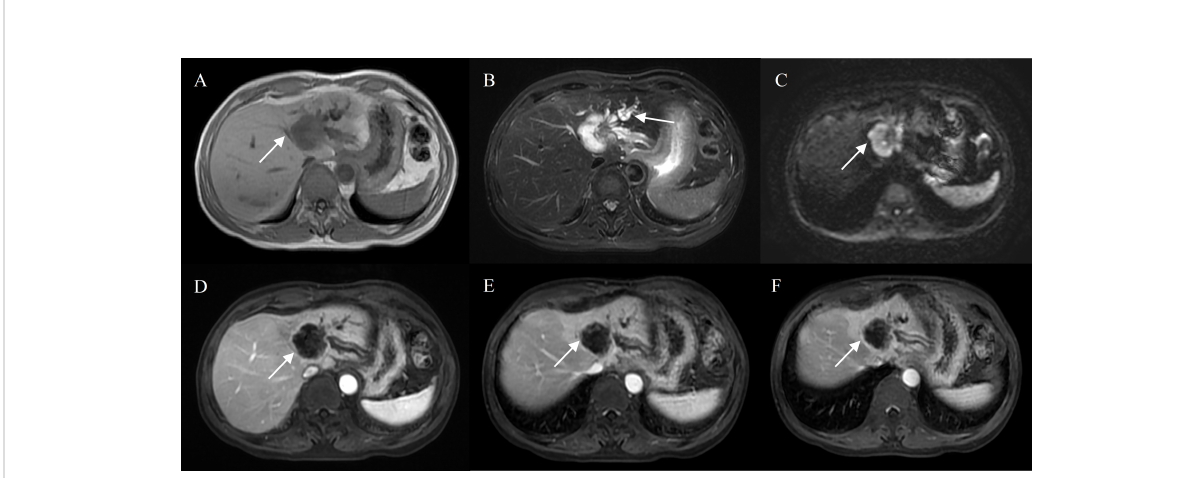
FIGURE 5 Intrahepatic mass-forming cholangiocarcinoma in a 70-year-old male without chronic viral hepatitis. Gd-DTPA-enhanced MRI detected a lobulated tumor (4.3 cm) with homogeneous SI on T1WI and T2WI (A, B) , restricted diffusion (C) . Peripheral rim-like enhancement in the arterial phase (D) , sustained rim enhancement in the portal and delayed phase (E, F) . And bile duct dilation peripheral to the tumor (B)